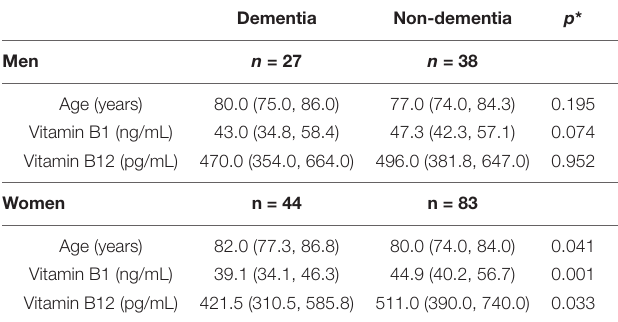
TABLE 4 | Comparisons of characteristics between the dementia group (HDS-R ≤ 20) and the non-dementia group (HDS-R > 20) according to sex.